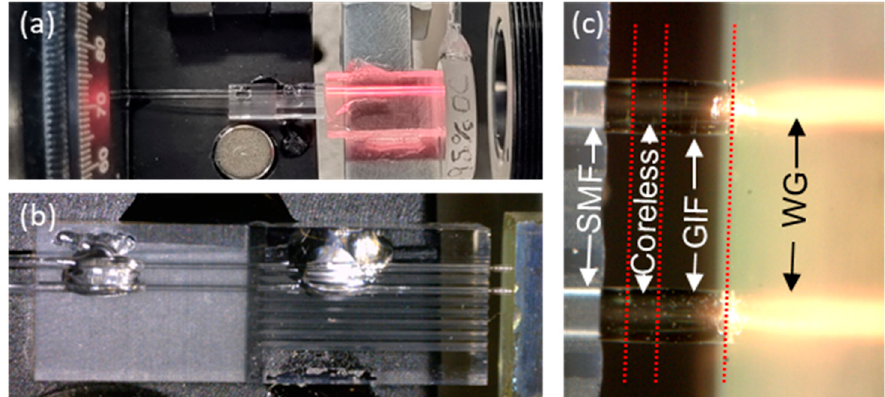
Figure 3. Ho:ZBLAN WG laser images. ( a ) From left to right the image shows the pair of delivery fibers with their GIF-tips mounted onto the V-groove array, the Ho:ZBLAN substrate including the WG’s visible owing to their fluorescence emission, and the 95%R resonator mirror laminated onto the end of the Ho:ZBLAN substrate. ( b ) Close-up view of the V-groove array with two UV epoxy regions clearly visible and the protrusion of the GIF-tips from the V-groove facet evident. ( c ) Close-up view of the free-space junction between the V-groove array and the WGs. Segments of the optical sections are noted, with boundaries indicated by red dotted-lines.